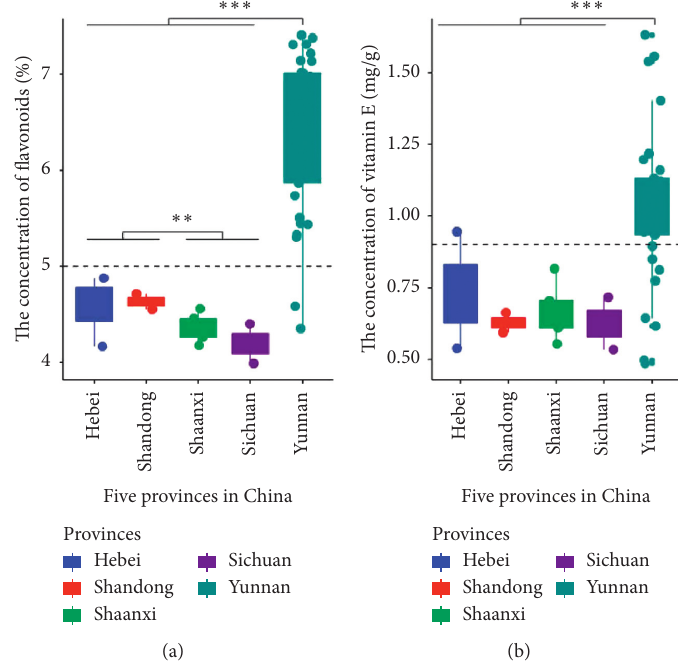
Figure 2: (a) The percentage of flavonoids and (b) the concentration of vitamin E in 45 different types of walnut kernels from the main five walnut-planting provinces in China. Dunnett’s multiple-comparison tests were implemented for statistical analysis. Raw p value was labeled, ∗ p < 0 . 05, ∗∗ p < 0 . 01, and ∗∗∗ p < 0 .